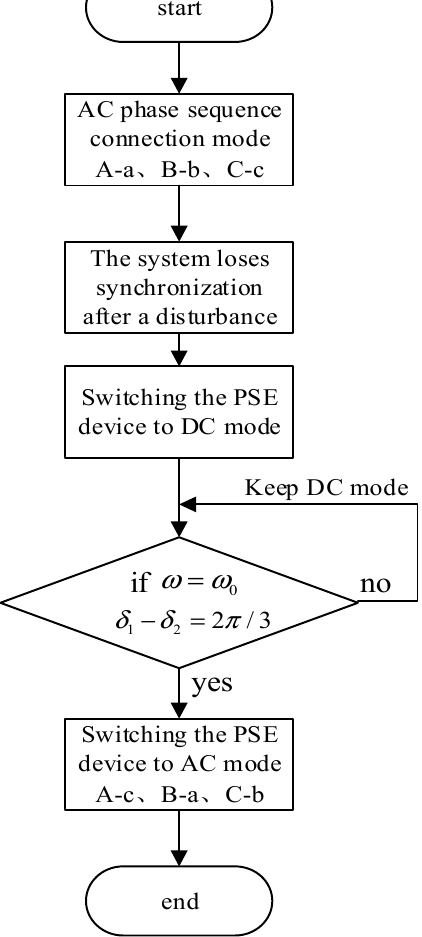
Figure 15. The flow chart of the PSE